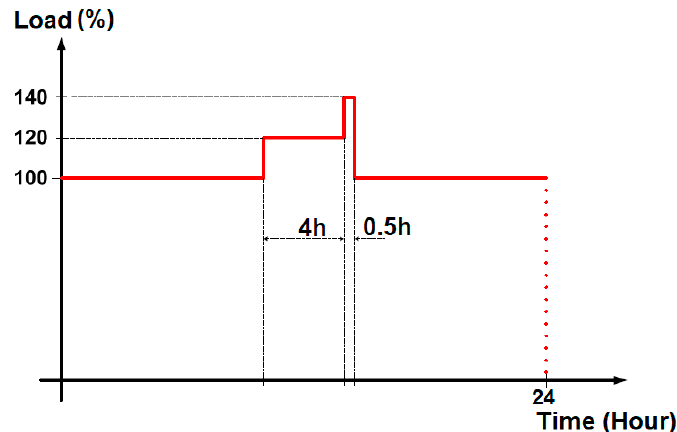
Figure 7. Acceptable Over Load by ONS NT 038/2014.